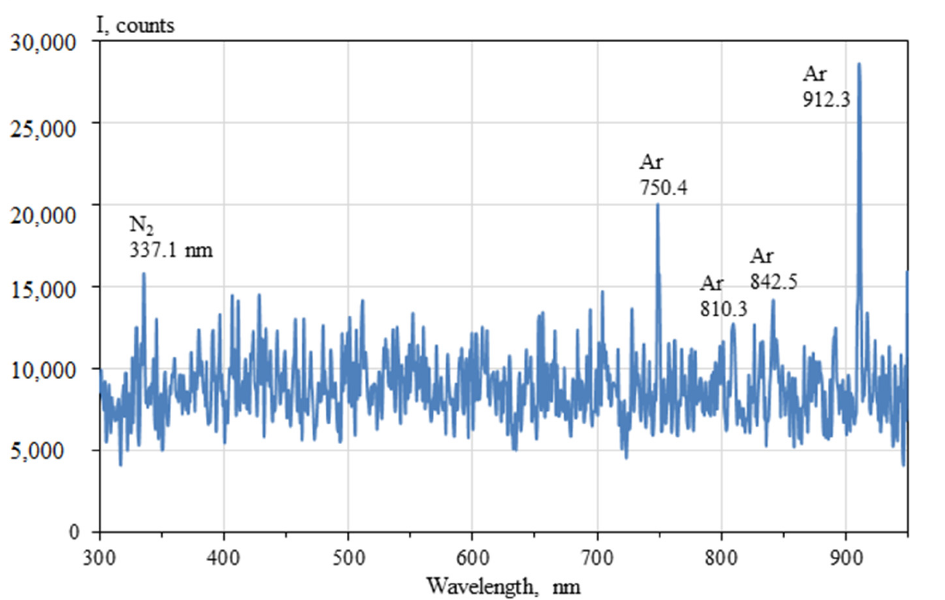
Figure 9. Spectrum of He(702 Torr) + Ar (1.7 Torr) mixture radiation. Lithium layer temperature before reactor start up is 386 K.